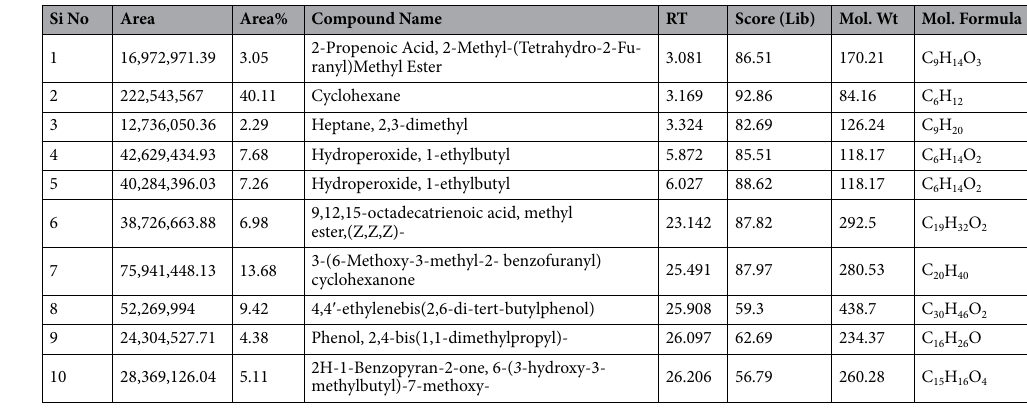
Table 6. The major components found in the PC4 fraction (Acetone : Methanol) of Hexane extract.